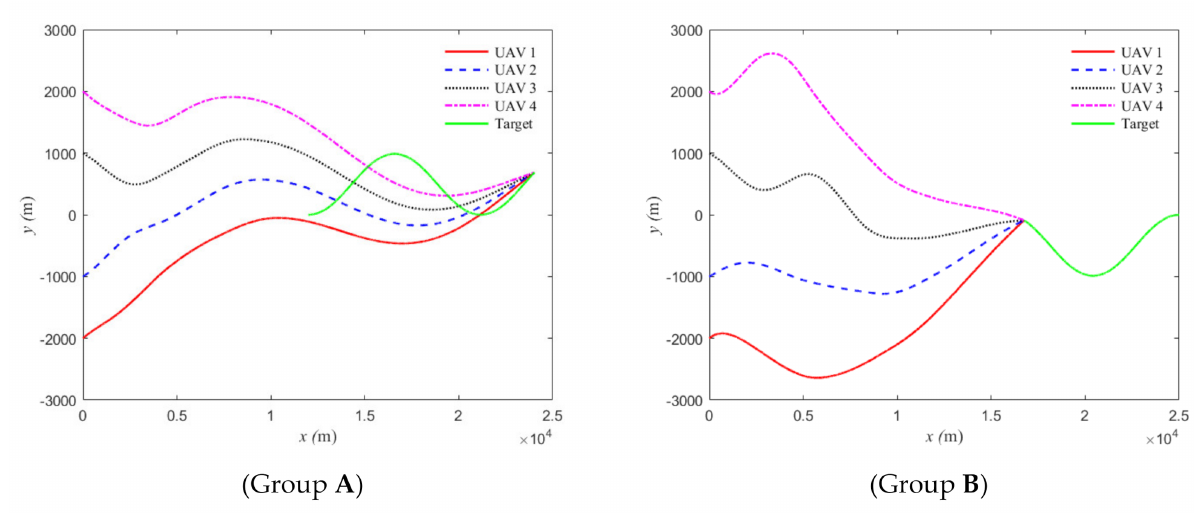
Figure 3. Trajectories of four UAVs to attack a maneuvering target simultaneously.